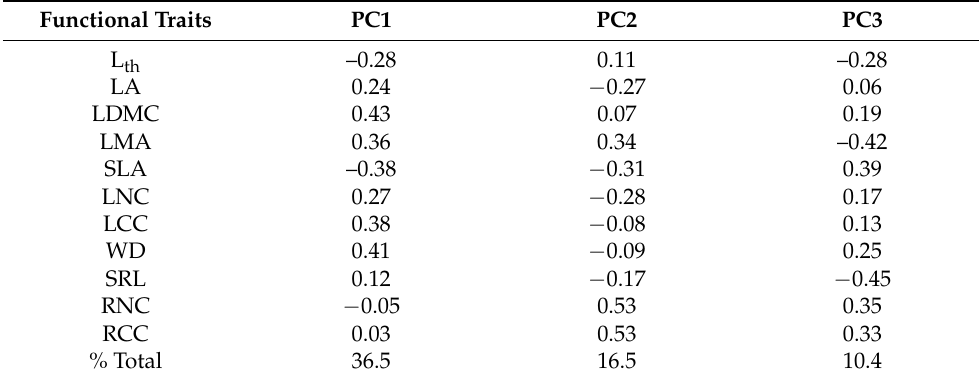
Table 2. Principal component analysis results of functional traits for lianas and trees. Functional